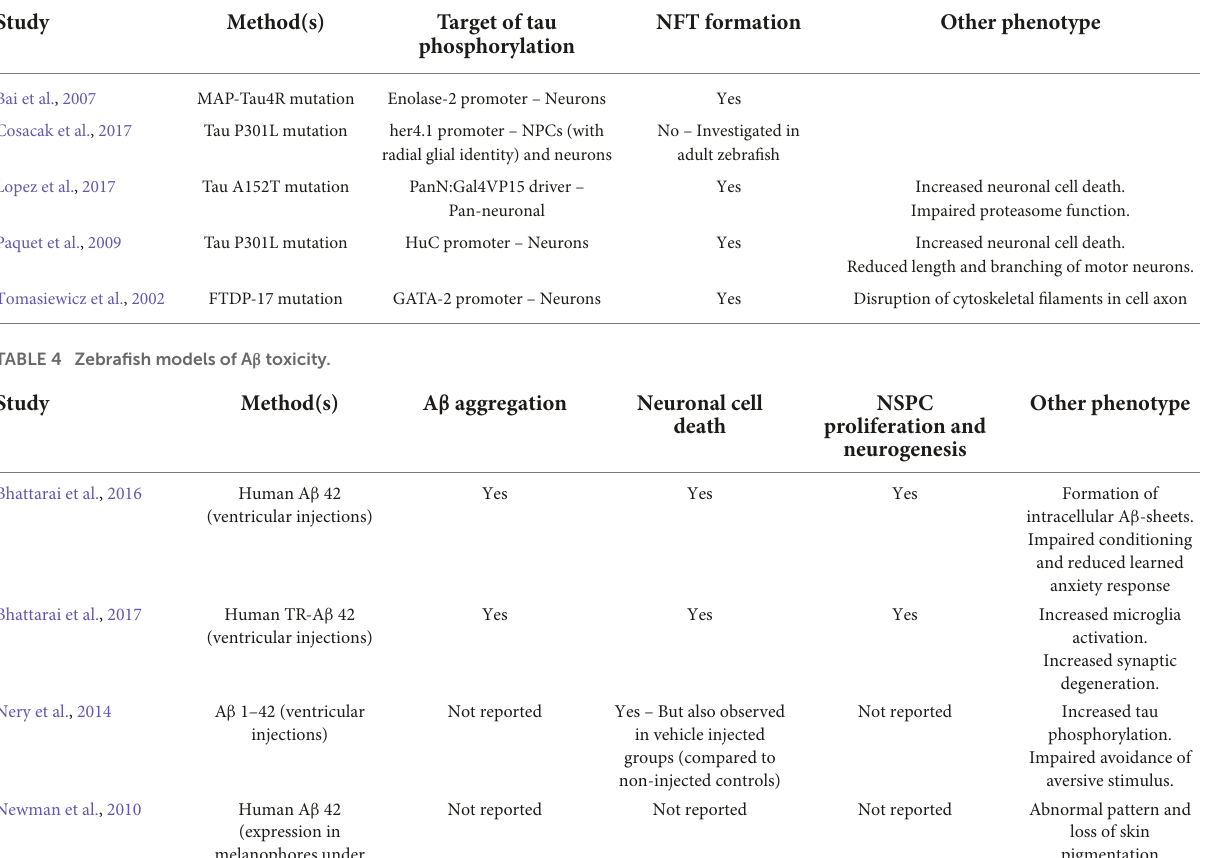
TABLE 3 Zebrafish models of tauopathy.